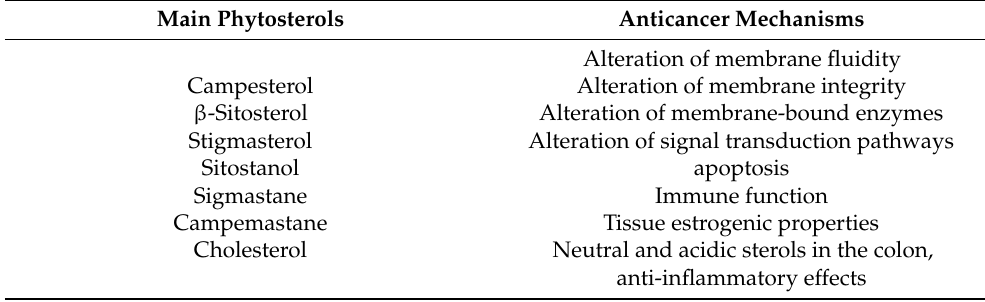
Table 1. Phytosterols and anticancer mechanisms.